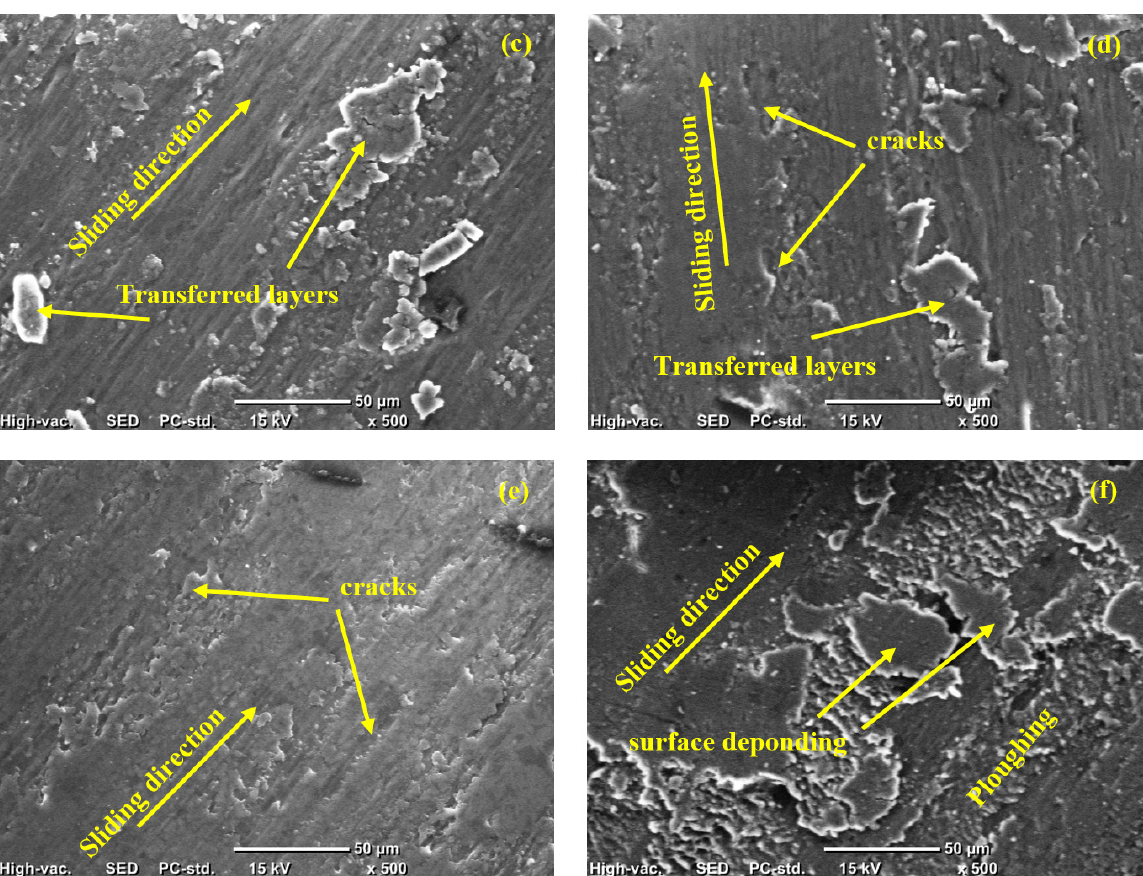
Figure 14. SEM of worn epoxy composite surfaces ( a ) ECC0, ( b ) ECC2, ( c ) ECC4, ( d ) ECC6, ( e ) ECC8, and ( f ) ECC10.